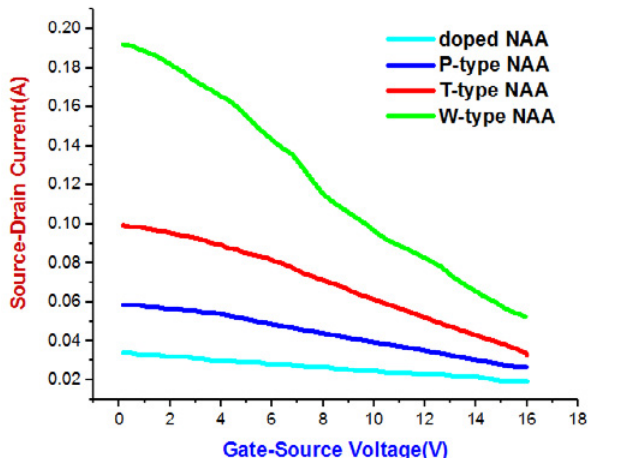
Fig. 5. Source-drain current versus gate-source voltage for different alumina-tin nanocomposite